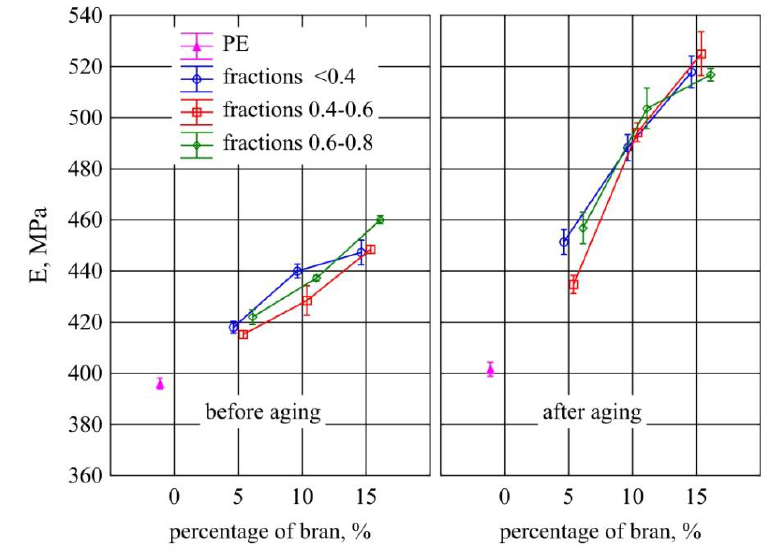
Figure 21. Young’s modulus of injection mouldings before and after aging depending on the mass content and grain size of the introduced bran fraction (average values with standard deviation).